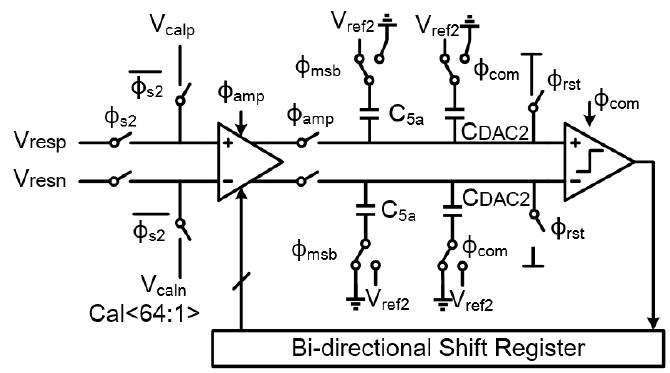
Figure 2. Circuit schematic of the background calibration .